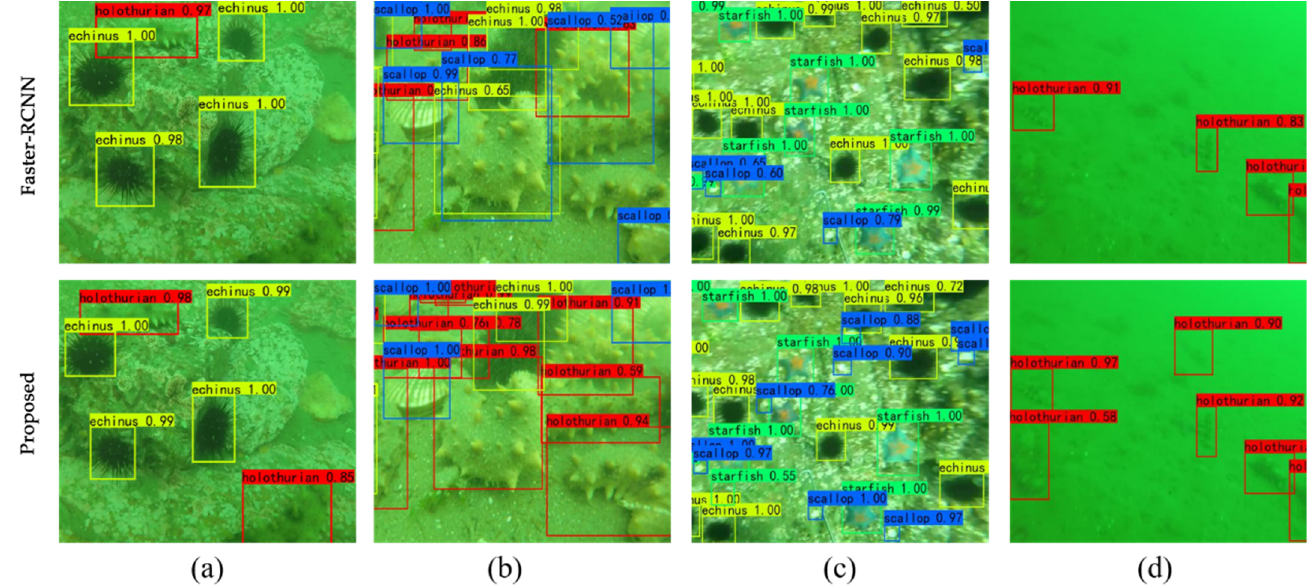
Figure 9. Comparison of test results: ( a ) detection of incomplete targets; ( b ) detection when targets are occluded or overlapped with each other; ( c ) detection of multi-scale targets; and ( d ) detection of fuzzy targets.